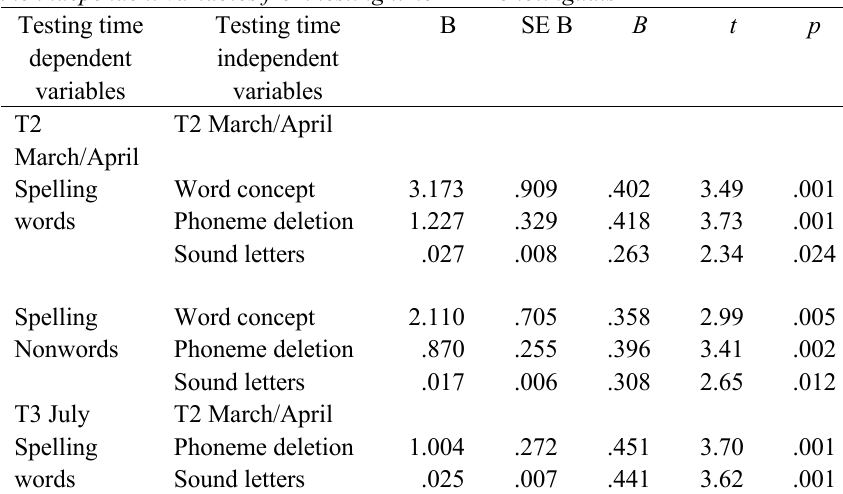
Table 4. Multiple regression analyses predicting spelling at testing times 2 and 3 with the independent variables from testing time 2 – Monolinguals